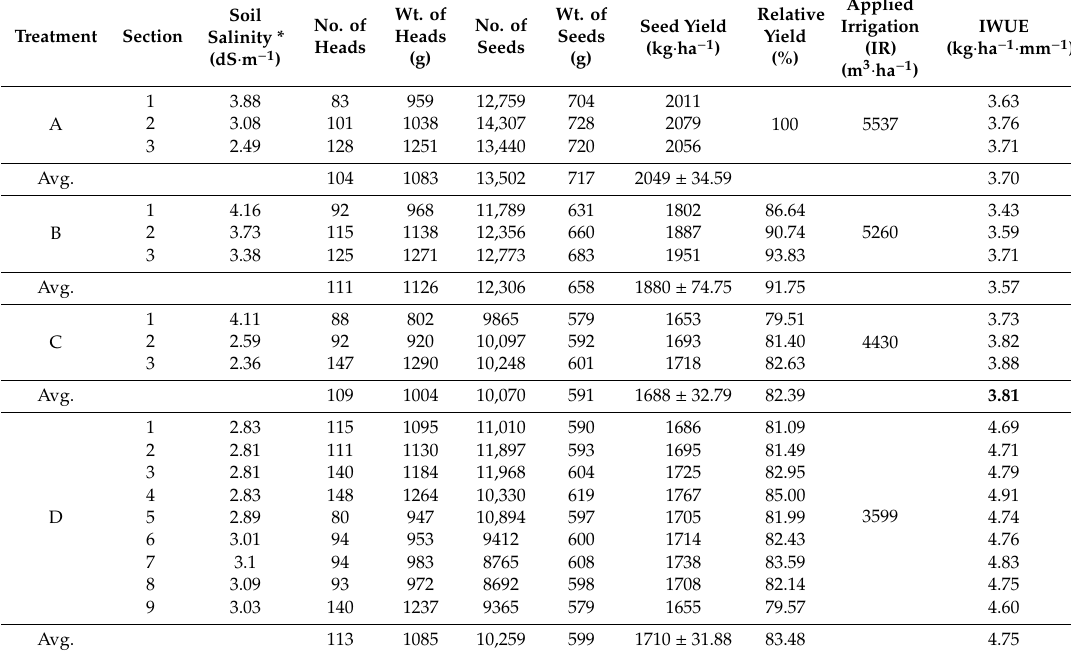
Table 9. Yield components and irrigation water use efficiency (IWUE) calculations for the 18 harvest locations.